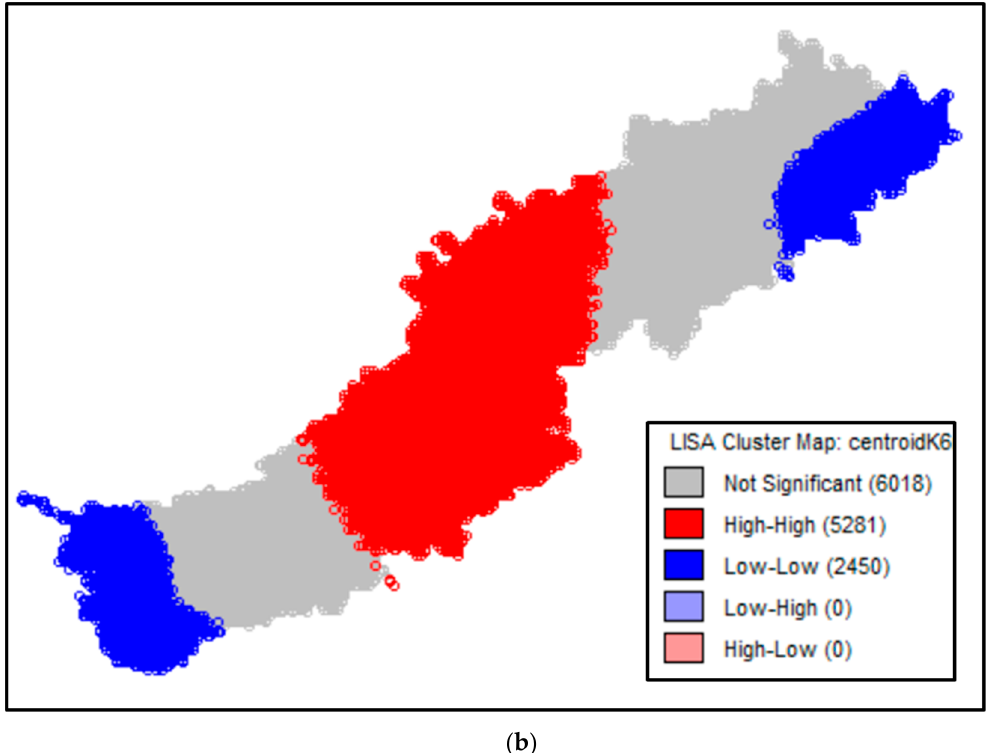
Figure 8. Autocorrelation map of the SDI (Sea Distance Index)—( a ) scatter plot and ( b ) cluster map.